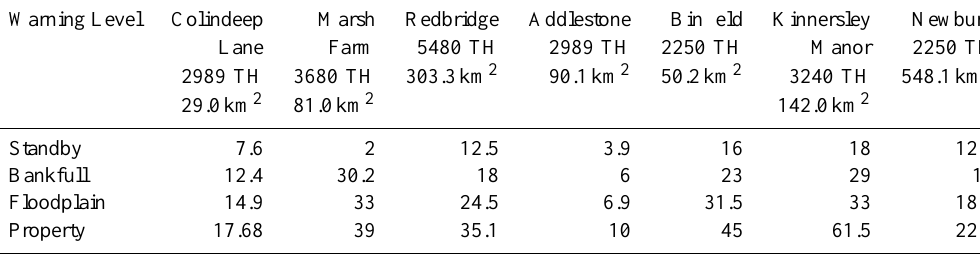
Table 1. Warning thresholds (m 3 s − 1 ) for locations (name, station identifier and area) used in the evaluation. Warning